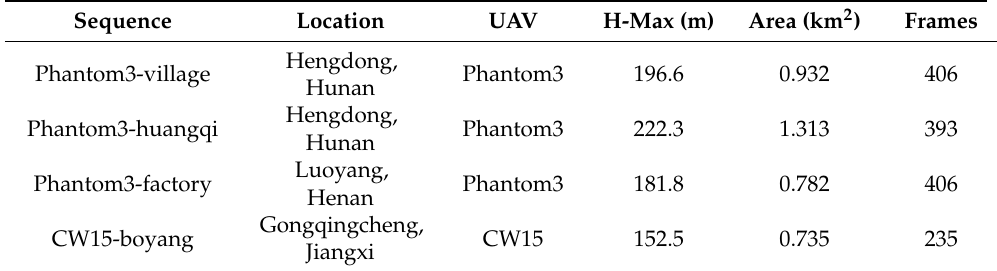
Table 2. Test Image Sequences Information. ‘H-max’ denotes the maximum flight height and “ Area ” denotes the area of